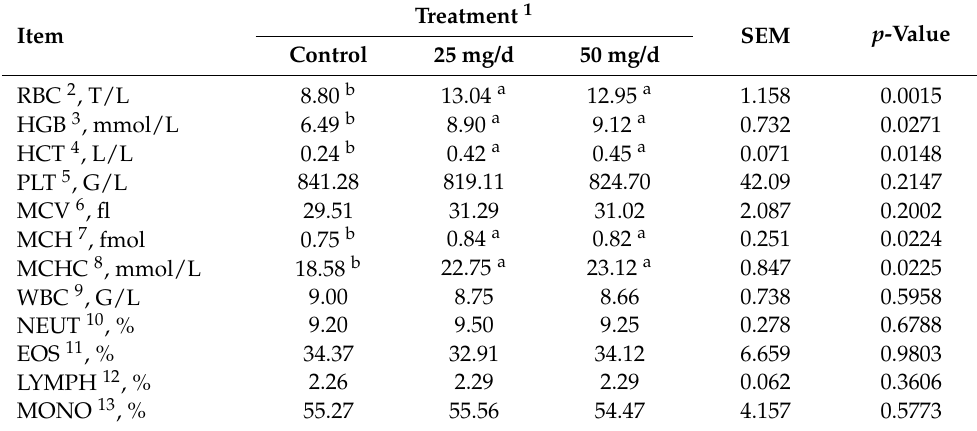
Table 2. The effect of organic iron supplementation on hematological parameters.